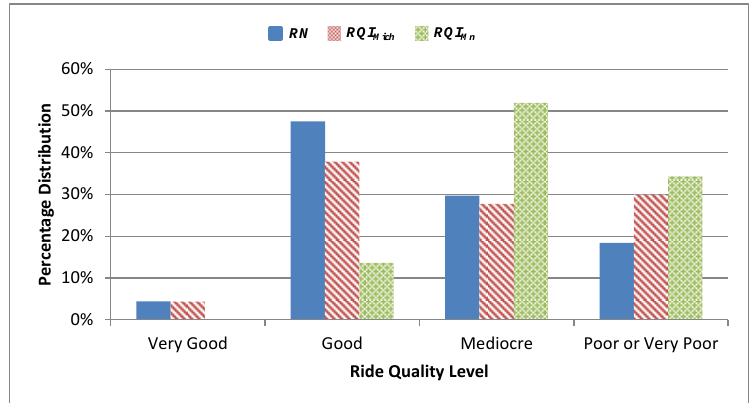
Figure 5. Ride Quality Level Percentage Distribution for the real profiles samples.